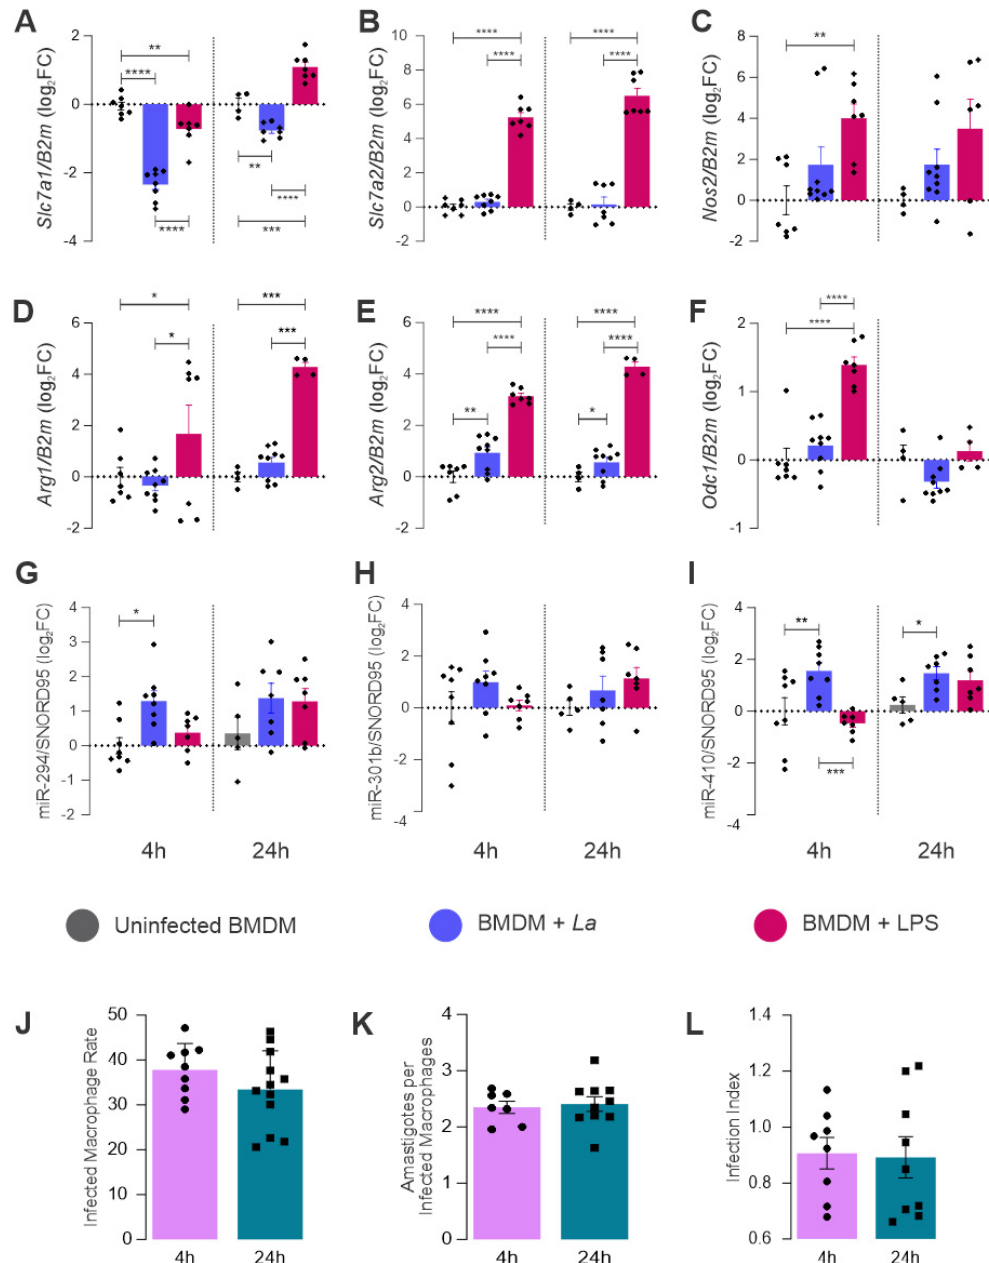
Figure 3. Quantification of L-arginine metabolism-related gene transcripts and miRNA levels on macrophages infected with L. amazonensis . Bone Marrow Derived-Macrophages were infected with stationary phase L. amazonensis promastigotes (MOI 1:5) or treated with LPS for 4 and 24 h. The total RNA was extracted and converted into cDNA to quantify transcripts of genes related to L-arginine metabolism through RT-qPCR: ( A ) Slc 7 a 12 ( B ) Slc 7 a 22 ( C ) Nos 2, ( D ) Arg 12 ( E ) Arg 22 and ( F ) Odc 1. The miRNAs levels were assessed through RT-qPCR: ( G ) miR-294, ( H ) miR-301b ( I ), and miR-410. The infected BMDM were fixed and Giemsa stained to assess the number of total macrophages ( n = 600), infected macrophages and amastigotes. ( J ) infected macrophage rate [(infected macrophage/total macrophage) * 100], ( K ) amastigotes per infected macrophage, and the product of infected macrophages rate with amastigotes per infected macrophage; ( L ) infection index (rate of infected macrophages multiplied by number of amastigotes per infected macrophage). Statistics: Each dot represents a biological replicate from three independent experiments. Mixed-effects analysis, post hoc test: Sidak’s multiple comparisons. p -values: *, p ≤